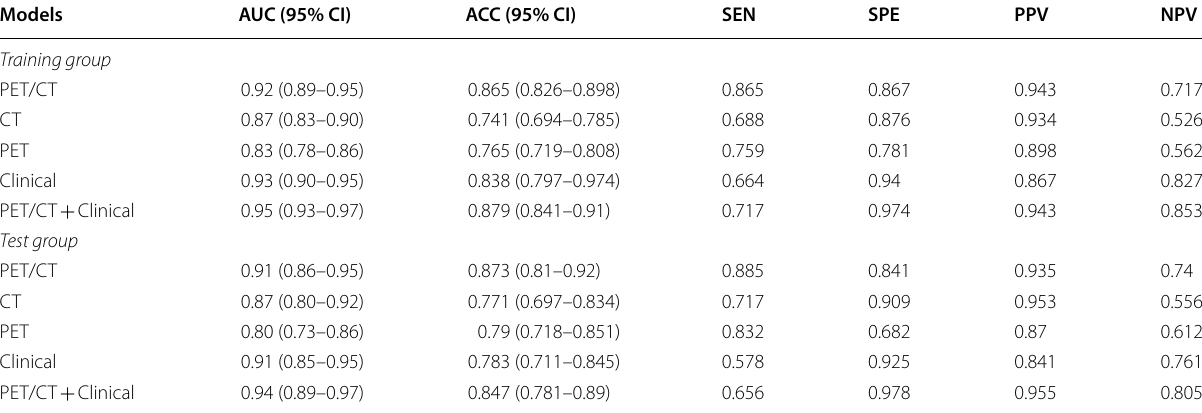
AUC: area under the curve; CI: confidence interval; ACC: accuracy; SEN: sensitivity; SPE: specificity; PPV: positive predictive value; NPV: negative predictive value. The PET/CT, CT, and PET models represent PET/CT, CT, and PET radiomics models, respectively